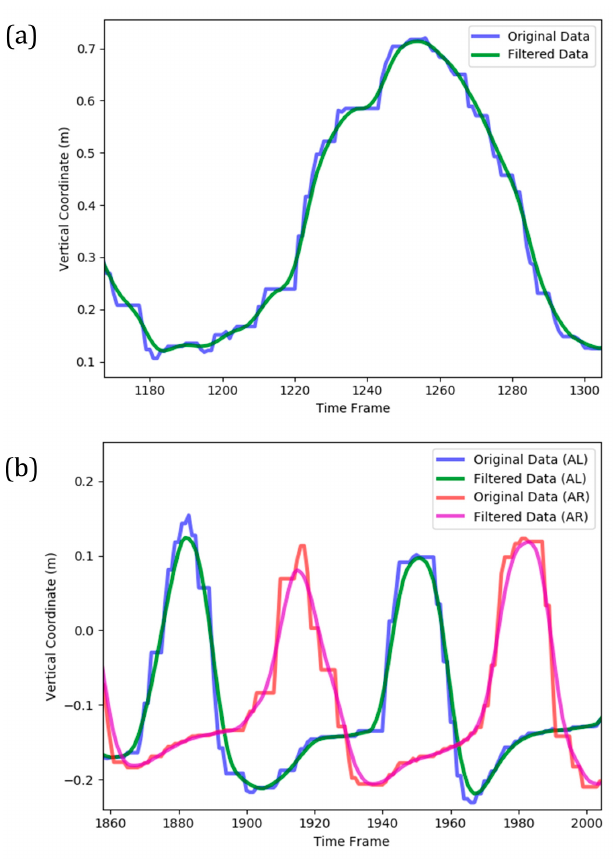
Figure 4. A sample for smoothing of Kinect data (vertical coordinate) by moving average Gaussian filter implemented on ( a ) a complete cycle of arm curl exercise; ( b ) two complete cycles of the two-minute steps exercise (AL and AR denote ‘AnkleLeft’ and ‘AnkleRight’ features, respectively).